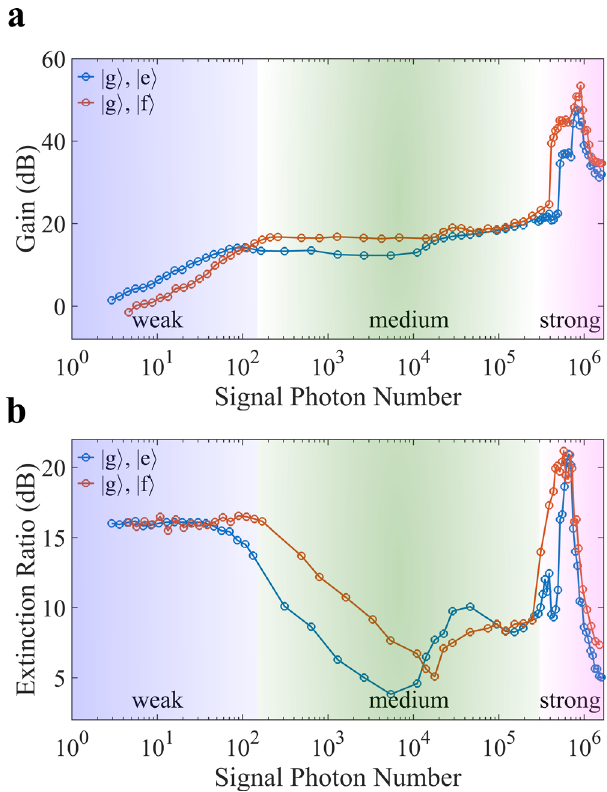
Fig.3|Gainandextinctionratio.a , b showtheextractedgainandextinctionratio of our device, respectively, when the transistor is fed with varied signal photon numbers from 3 to 1.6×10 6 . According to the signal strength and the resulting performance of the transistor, three operation ranges of the transistor are distinct withdifferentcolors.Blueandredplotsaretheexperimentalresultswhenthequbit (cid:1) (cid:1) (cid:1) g subspace, correspondingly. Note is operated in the f ∣ g , ∣ e ig subspace or f ∣ g , ∣ f that since we pick up the best-measured gain and extinction ratio for each of the input signal strengths, the signal frequency is not necessarily kept